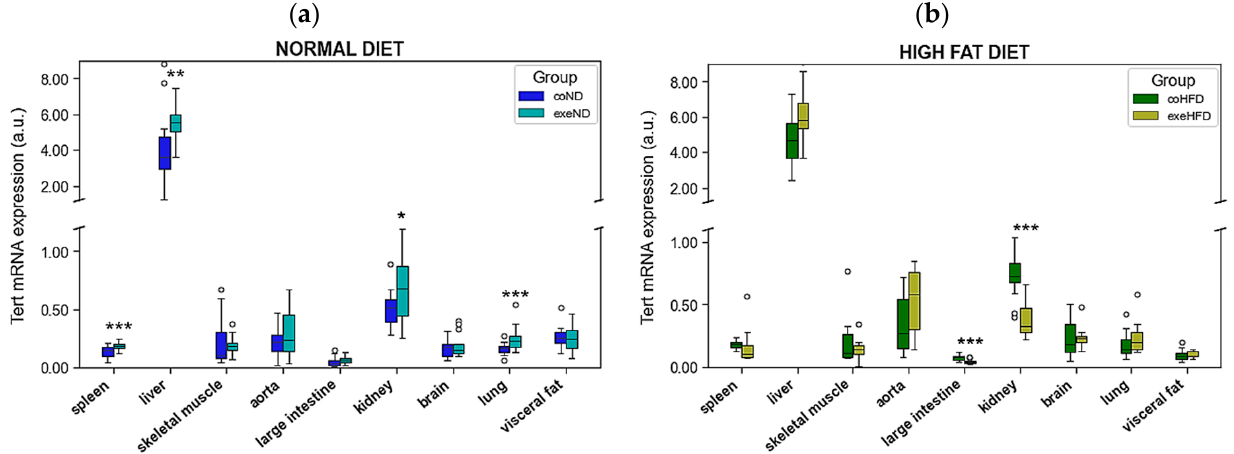
Figure 5 . Comparison of RTL in PBMCs and nine solid organs isolated from exercising and seden- tary SD rats that received normal diet or HFD for 10 months. ( a ) sedentary (coND) vs. exercising (exeND) animals on ND, ( b ) sedentary (coHFD) vs. exercising (exeHFD) animals on HFD. Outliers are shown as white circles above the box plots. RTL is expressed as ratio of average telomere length to the reference gene GAPDH. The two-tailed Student’s t-test or the Mann–Whitney U-test were used for group comparison of independent samples. * p < 0.05, ** p < 0.01, *** p < 0.001 vs. respective sedentary controls.